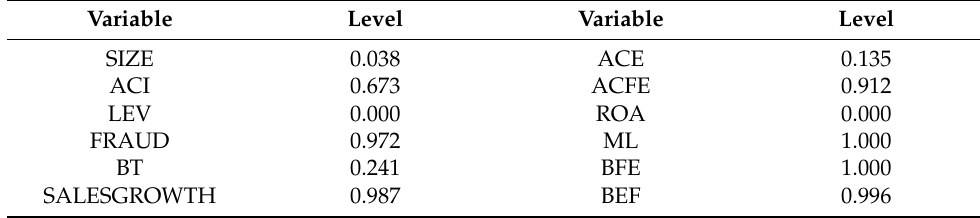
Table 5. Test results for normality of variables.